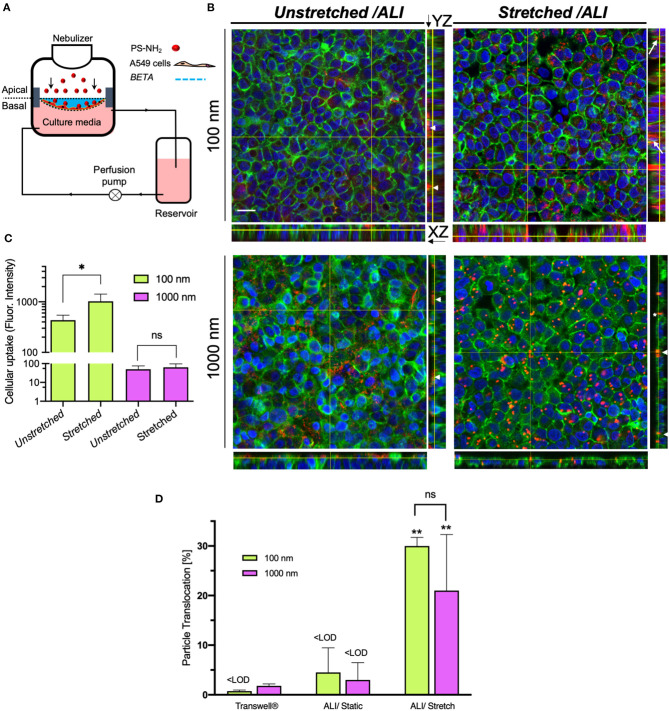
Cellular uptake and membrane-association of aerosolized nano- and microparticles for alveolar epithelial (A549) cells and translocation across the epithelial barrier (2 h incubation). (A) Schematic of the CIVIC bioreactor system for particle study. A549 cells were seeded on the BETA membrane (cell density: 2 × 105 cells cm−2, 4 days LLC, and 1-day ALI culture). Amine-modified polystyrene (PS-NH2) nano- and microparticles (100 and 1,000 nm diameter, respectively) are then nebulized onto the cells with the nebulizer of the bioreactor. After 2 h, the cells were fixed and prepared for CLSM analysis. (B) 3D reconstruction z-stack of CLSM images presented as orthogonal (XY) and side views (YZ, right) of monolayered, confluent cells on the membrane after nebulization of 100 and 1,000 nm fluorescently labeled, amine-modified polystyrene (PS-NH2) particles under non-stretched and physiologically stretched (10% linear, 0.33 Hz for 2 h) under ALI conditions. Cell nucleus (DAPI, blue), particles (red) and F-actin filaments of the cytoskeleton (green). Arrows, arrowheads, and asterisk indicate internalized particles, cell-membrane associated (extracellular) particles (on the apical cell surface) and particles located between cells, respectively. (Scale bar: 20 μm). (C) Quantitative cellular uptake of particles measured by fluorescence intensity of z-stacks, showing that physiologic cyclic mechanical stretch enhances uptake of 100 nm NPs as compared to static conditions, while there is no effect on 1,000 nm microparticles [Representative images (z-stacks) were recorded at 5 independent fields of view for each sample (n = 4); region of interest: 134.95 × 134.95 μm]. Y-axis is presented fluorescence intensity data in a log scale. Data are reported as the mean ± SD; *P < 0.01 by two-way ANOVA and data were corrected by Sidac for multiple comparison tests. (D) Translocation of 100 and 1,000 nm particles across the cell layer grown on unstretched PET Transwell® inserts and on the BETA membrane (under unstretched and stretched conditions) (n = 3). ** Show the comparison between stretched with the corresponding experiment under unstretched conditions. Data are reported as the mean ± SD; **P < 0.001 by two-way ANOVA and data were corrected by Tukey for multiple comparison tests.